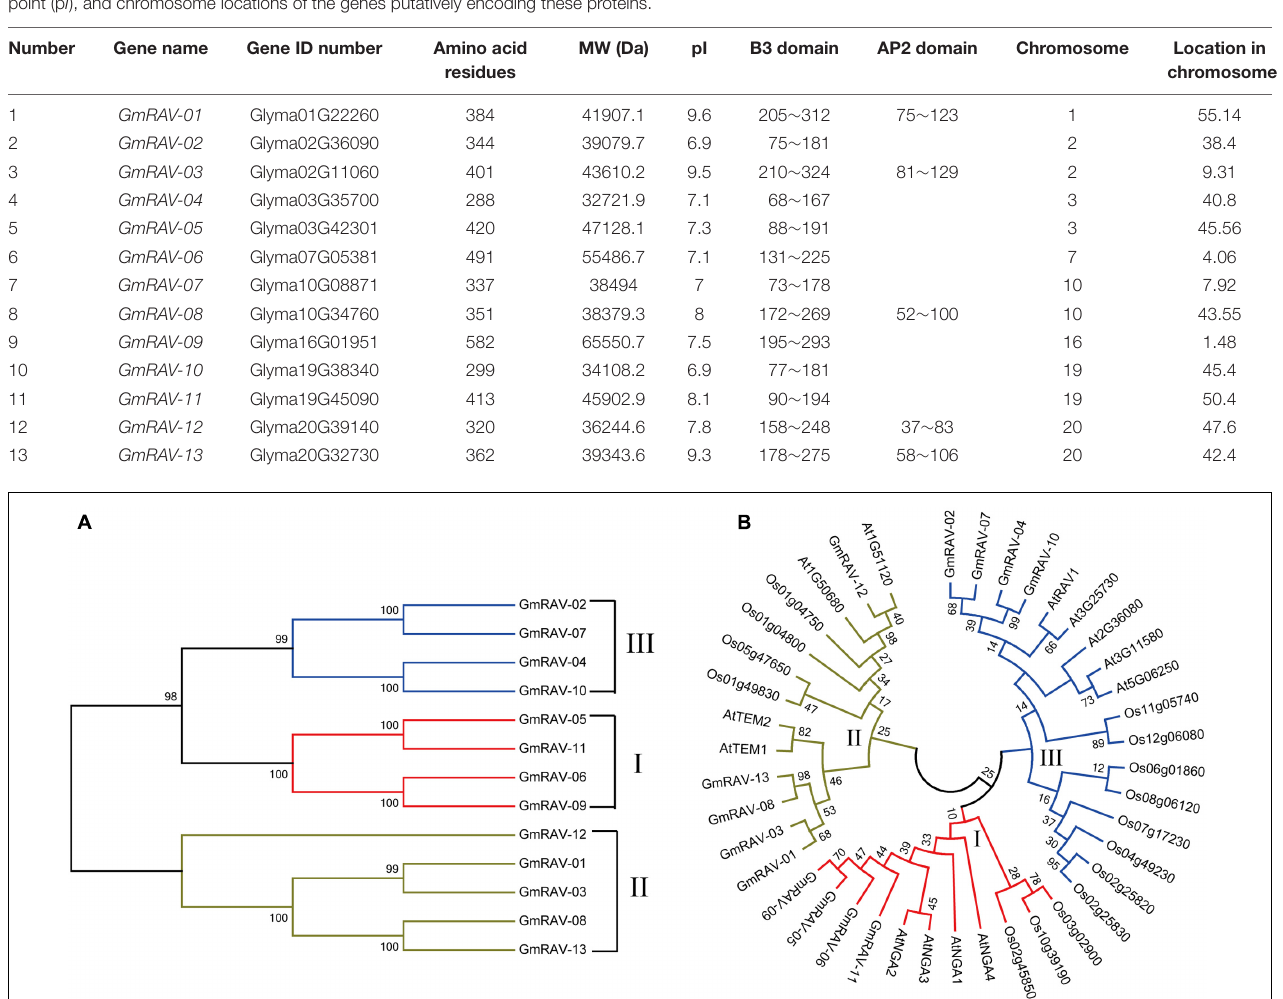
TABLE 1 | Protein information for the soybean RAVs, including sequence ID, predicted protein sequence length, predicted molecular weight (MW), predicted isoelectric point (p I ), and chromosome locations of the genes putatively encoding these proteins.